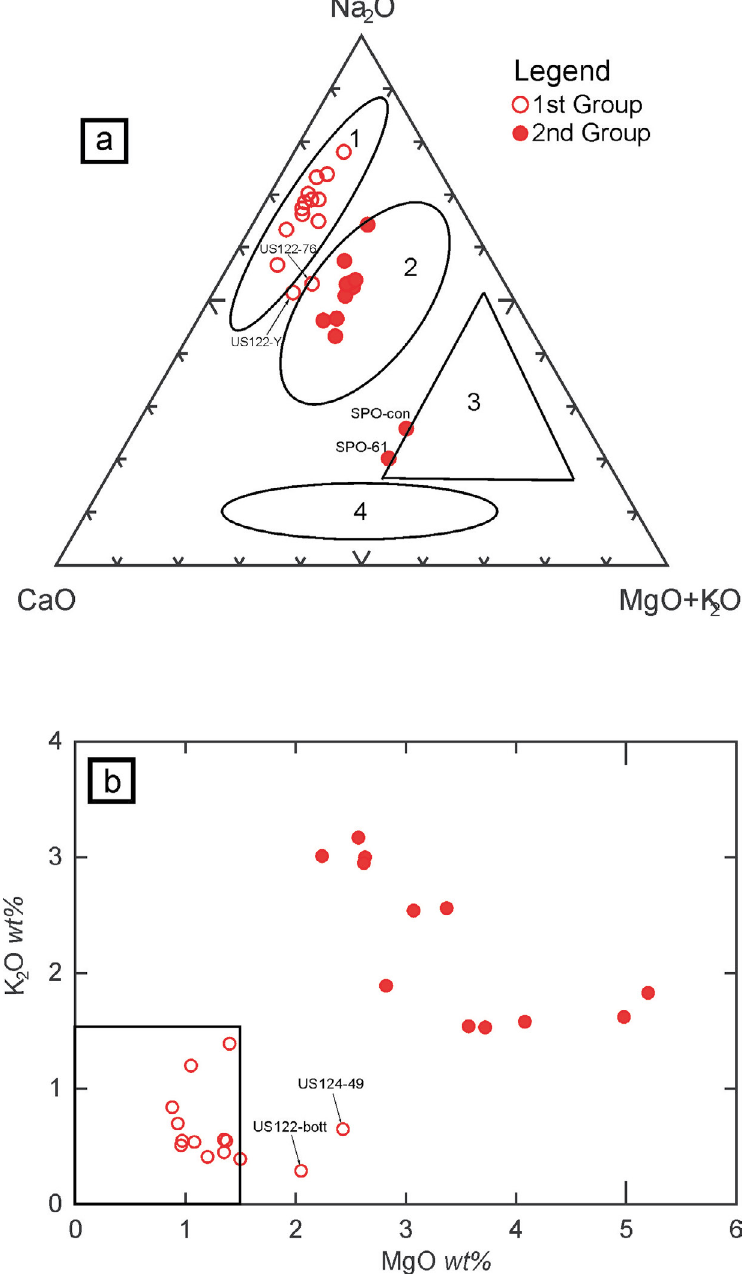
O – K O+MgO. The four main groups of historical glass are drawn on the plot: (1) mineral Figure 4: a) Ternary plot CaO – Na 2 2 silica-soda-lime glass typical of the 1st millennium BCE–1st millennium AD; (2) vegetable silica-soda-lime glass of the medie- val period; (3) mixed alkali glass of the late Bronze Age and medieval period; (4) potash glass of the medieval period (Gratuze, 2004; Hellemans et al., 2019). b) K O vs. MgO diagram: the square area discriminates the natron glasses. 2 The subgroup 1A includes nine samples (Tables 1 and 3) characterized by CaO around 5 wt% (from 4.86 to 6.11 wt% ) and Al O around 3 wt% (2.73 -3.73 wt% ). In addition, as regards FeO, these samples display 2 3 values varying from 1.56 to 3.41 wt% and are typically dark green in